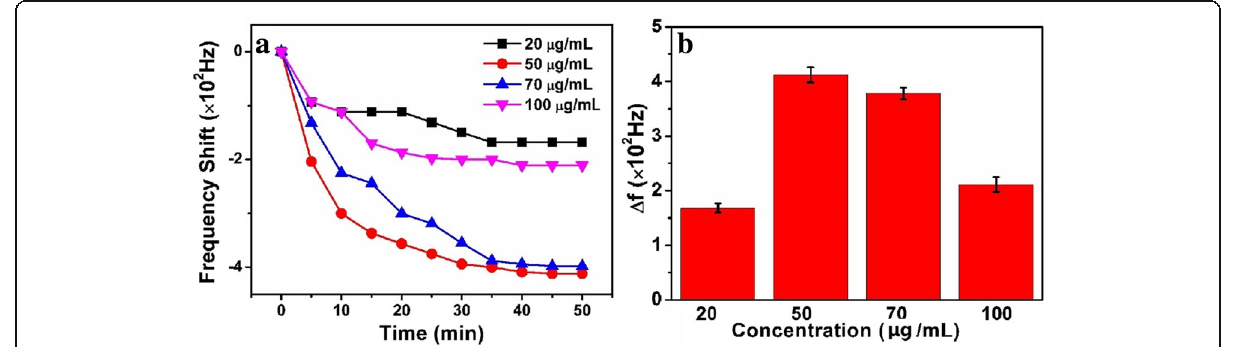
Fig. 4 a The curve of frequency response versus CEAAb. b Frequency histogram